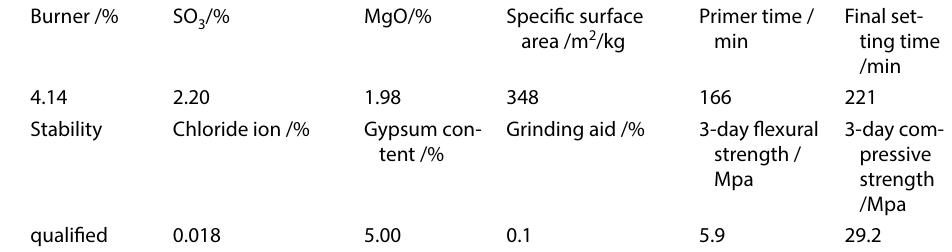
Table 3 Basic parameters of